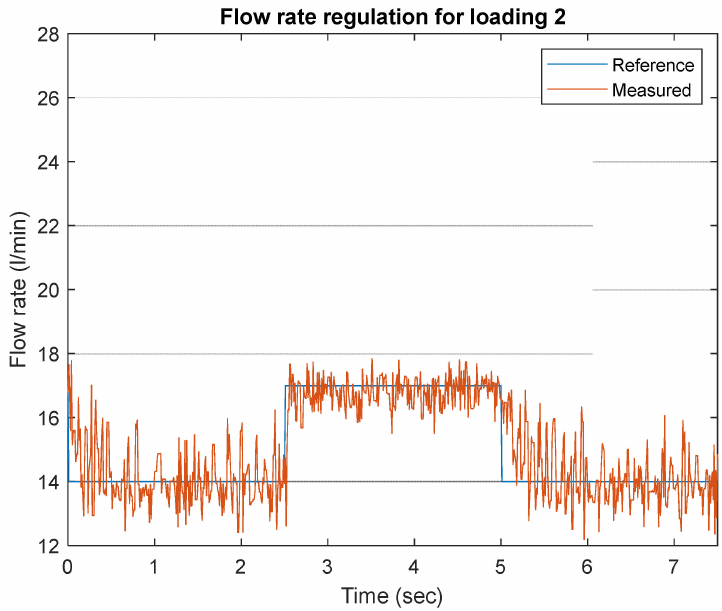
Figure 14. Experimental output flow rate data—loading 2.